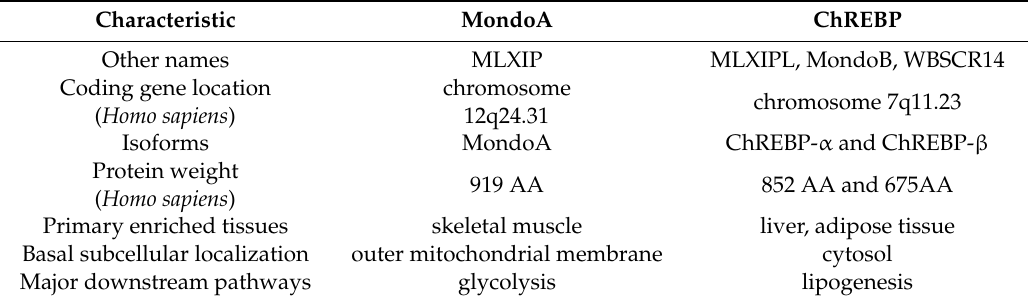
Table 1. Summary of characteristic di ff erences between MondoA and